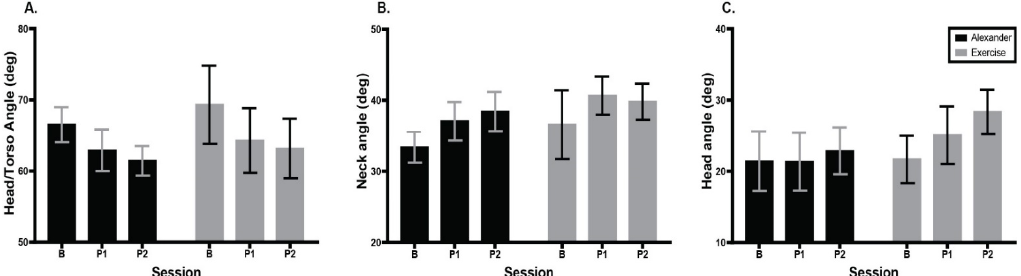
Figure 5. Comparison of posture during video-game task computed during 5 min play across groups and testing sessions. Errors bars are the standard error of the mean. ( A ) Head–torso angle (tragus, C7, manubrium). Higher angle indicates less forward head posture. ( B ) Neck angle (tragus, C7, horizontal). Higher angle indicates head farther back in space. ( C ) Head angle (orbit, tragus, horizontal). Higher angle indicates head extension. Error bars are the standard error of the mean. B = baseline; P1 = 1st post-test; P2 = 2nd post-test.